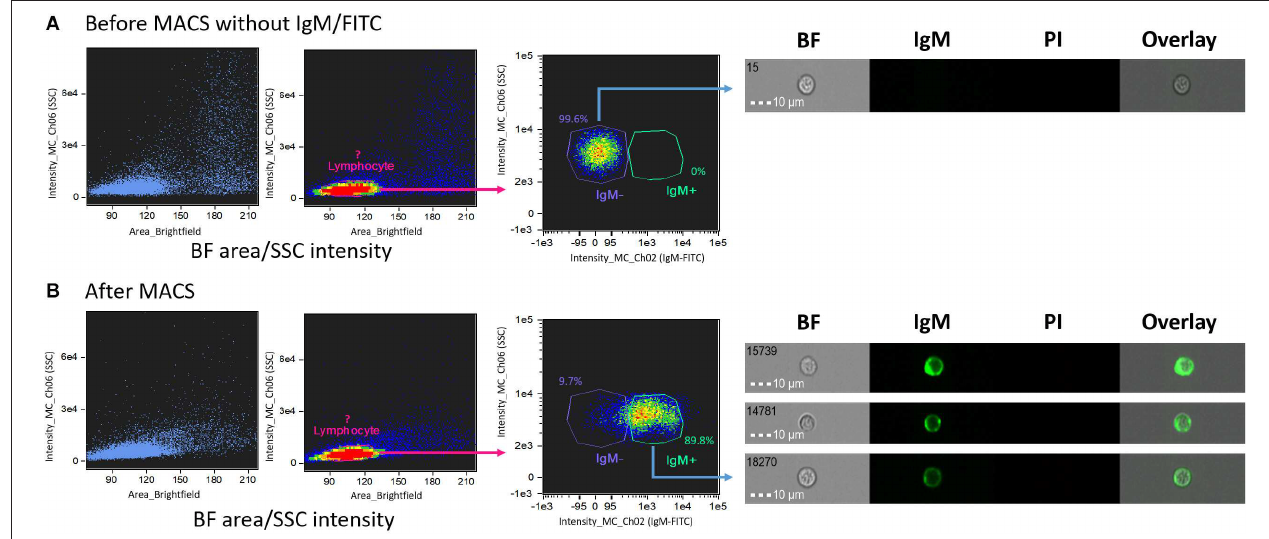
FIGURE 2 | Identification of salmon IgM + lymphocyte after magnetic-activated cell sorting (MACS). Dot plots of (A) HK leukocytes before and (B) after MACS separation. The left and middle plots in (A,B) show brightfield (BF) area vs. SSC intensity and the right plot in (A,B) shows the density of the target cells. Cells without IgM-FITC are shown in the IgM − gate ( A , right panel) while IgM + cells after MACS are shown in the IgM + gate ( B , right panel). All cell images were captured with 40 × objective. Scale bar = 10 µ m. BF, brightfield; IgM, immunoglobulin M; PI, propidium iodide.